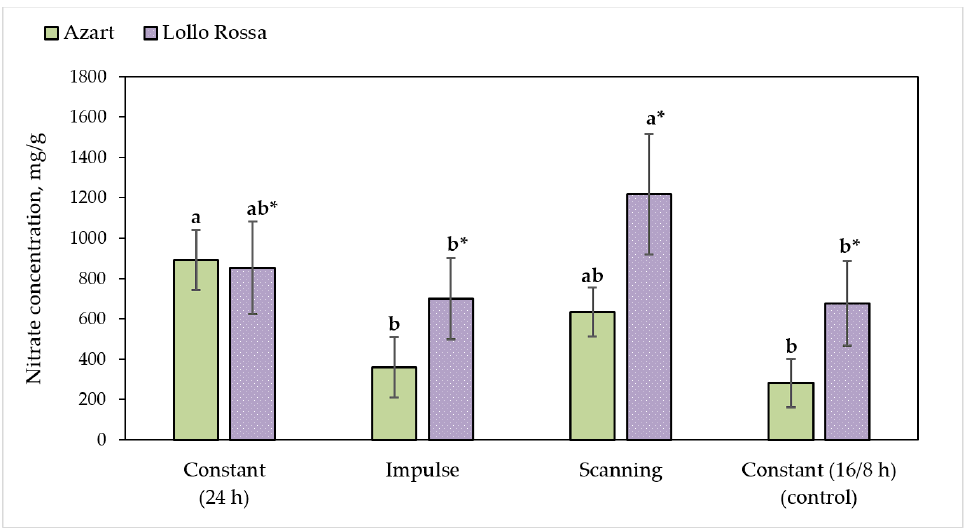
Figure 3. The concentration of nitrates on the 35th day of cultivation. Values represent mean SEM (n = 5). Letters indicate significant differences among treatment and control samples of ‘Azart’ variety, letters with asterisk sign –of ‘Lollo Rossa’ variety (p < 0.05).